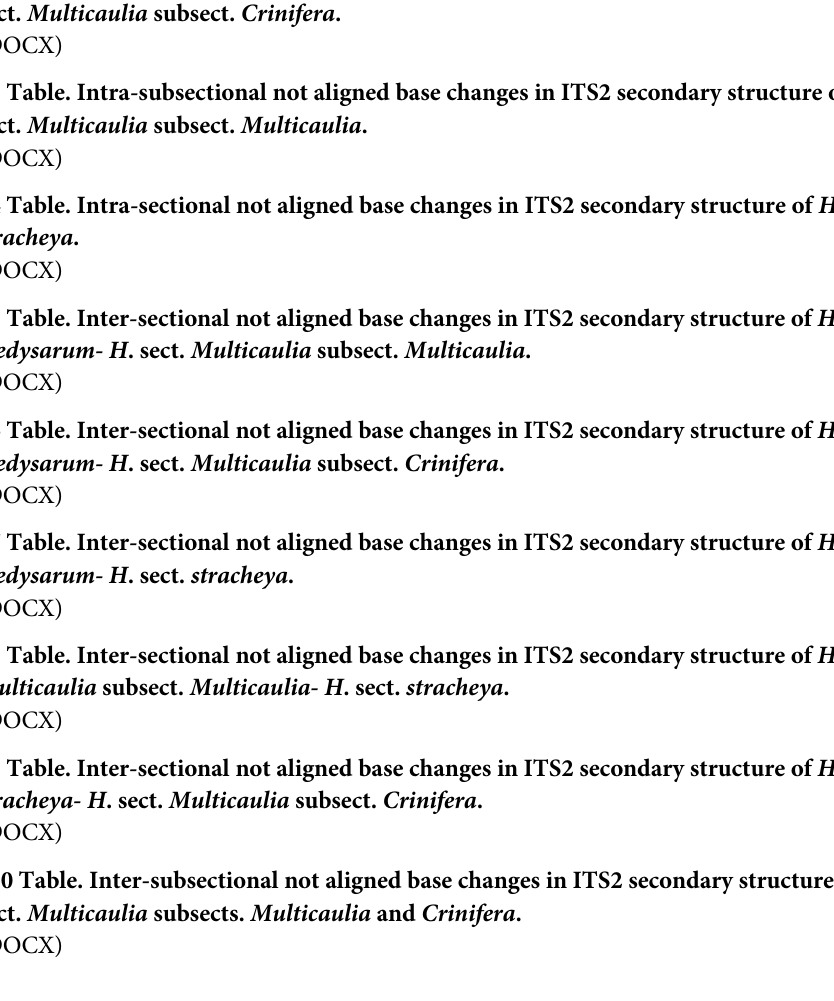
S1 Table. Intra-sectional not aligned base changes in ITS2 secondary structure of H . sect. Hedysarum . S2 Table. Intra-subsectional not aligned base changes in ITS2 secondary structure of H . sect. Multicaulia subsect. Crinifera . S3 Table. Intra-subsectional not aligned base changes in ITS2 secondary structure of H . sect. Multicaulia subsect. Multicaulia . S4 Table. Intra-sectional not aligned base changes in ITS2 secondary structure of H . sect. stracheya . S5 Table. Inter-sectional not aligned base changes in ITS2 secondary structure of H . sect. Hedysarum - H . sect. Multicaulia subsect. Multicaulia . (DOCX) S6 Table. Inter-sectional not aligned base changes in ITS2 secondary structure of H . sect. Hedysarum - H . sect. Multicaulia subsect. Crinifera . (DOCX) S7 Table. Inter-sectional not aligned base changes in ITS2 secondary structure of H . sect. Hedysarum - H . sect. stracheya . S8 Table. Inter-sectional not aligned base changes in ITS2 secondary structure of H . sect. Multicaulia subsect. Multicaulia - H . sect. stracheya . (DOCX) S9 Table. Inter-sectional not aligned base changes in ITS2 secondary structure of H . sect. stracheya - H . sect. Multicaulia subsect. Crinifera . (DOCX) S10 Table. Inter-subsectional not aligned base changes in ITS2 secondary structure of H . sect. Multicaulia subsects. Multicaulia and Crinifera .